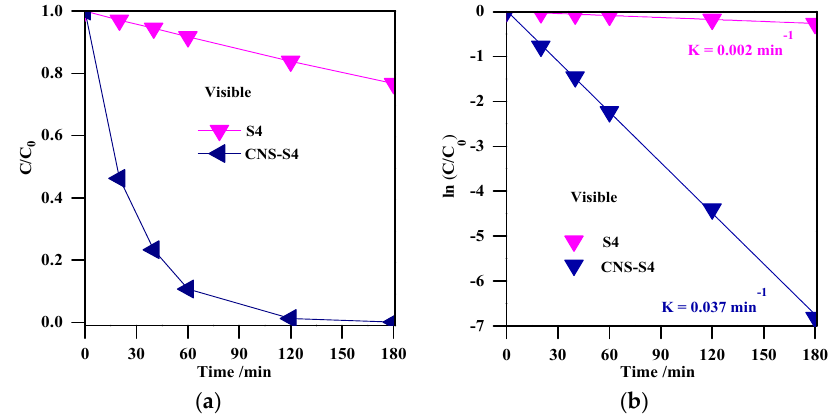
Figure 11. PL spectra of S1, S2, S3, S4, and CNS-S4 samples. 3. Materials and Methods